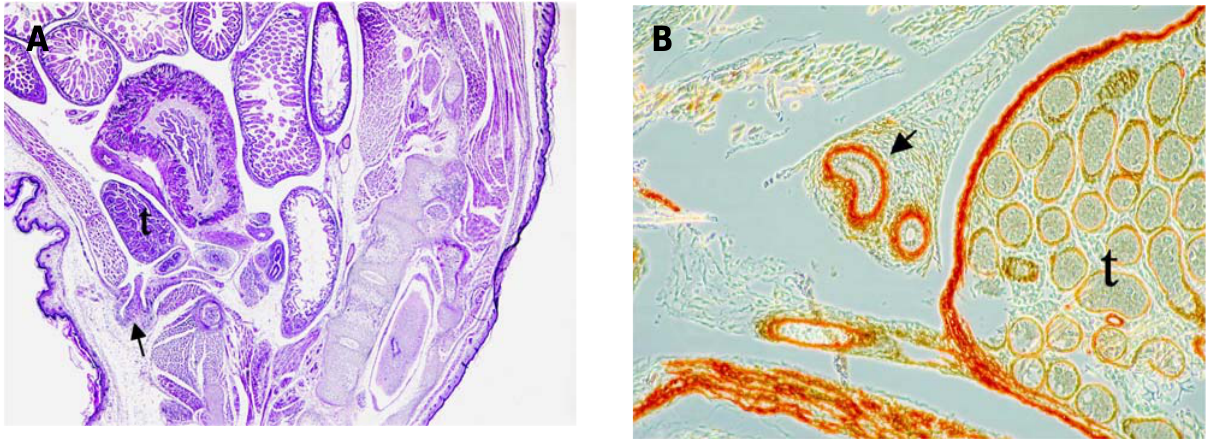
Figure 1 – A) Sagittal section of a heterozygous Insl3 mouse. The testis (t) is located at the bladder neck with developed cauda epididymis. The arrow points towards the gubernacular bulb, where the tip of the gubernaculum inserts. B) Immunostaining of the cauda epididymis showing strongly stained smooth muscle arranged in a circular fashion around the epididymal duct (arrow). The tunica albuginea and testicular peritubular connective tissue are also